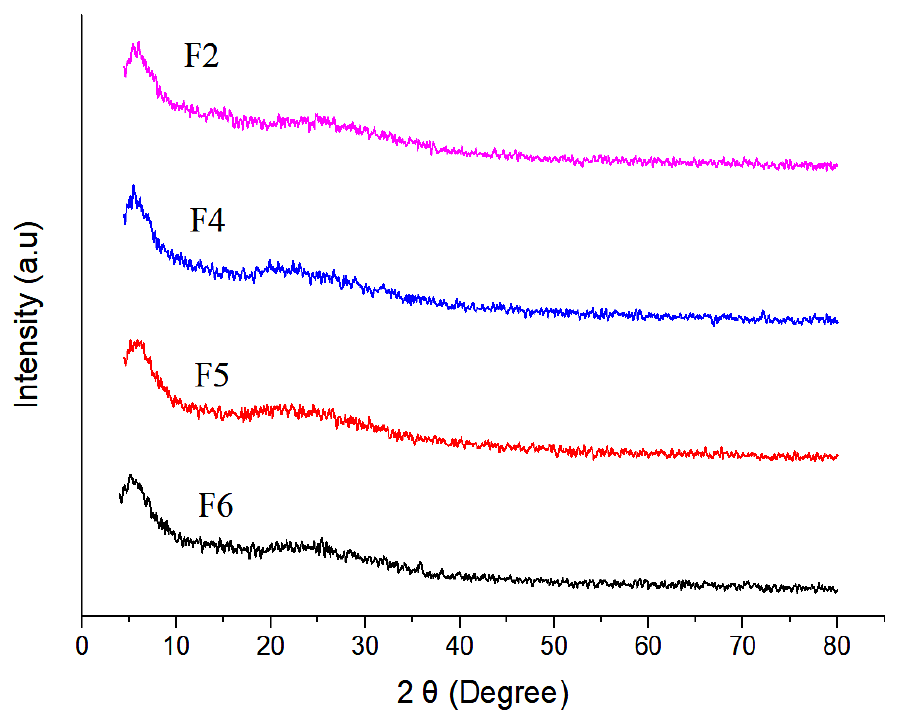
Figure 6. XRD analysis of selected nanoparticulate formulations.